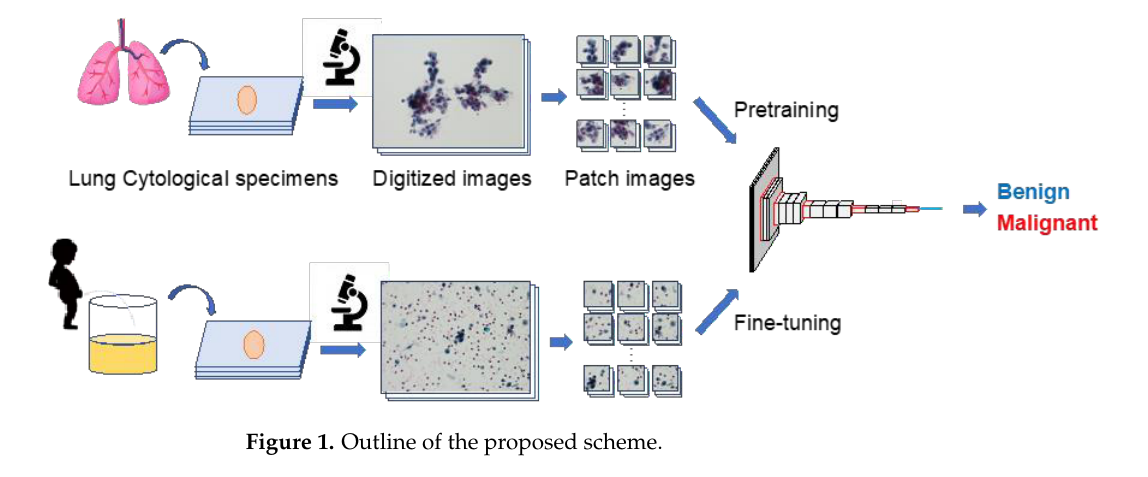
Figure 1. Outline of the proposed